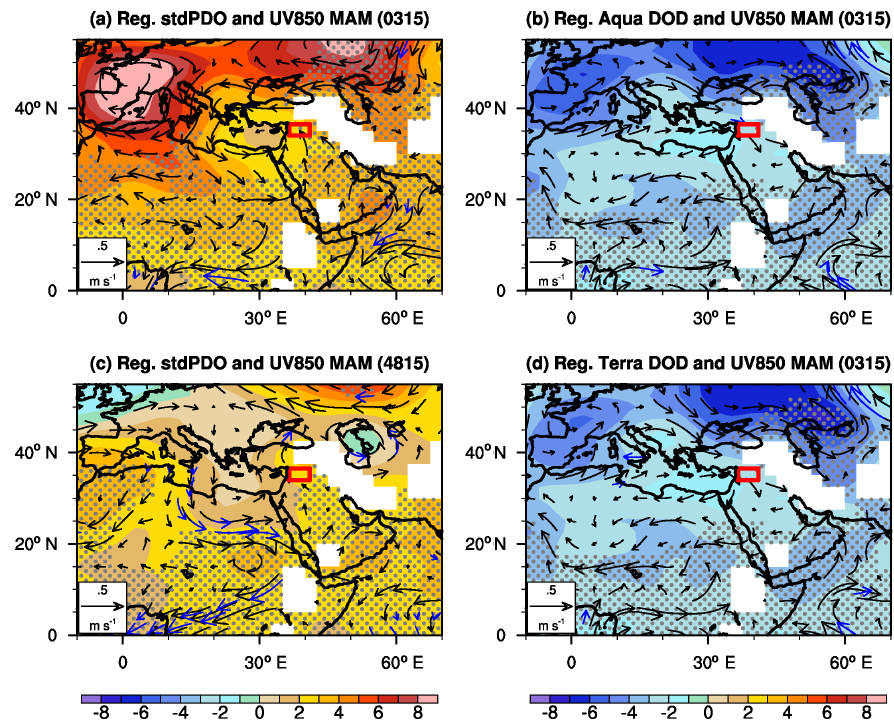
Figure 5. Regressions of NCEP1 850hPa geopotential height (shading; gpm) and horizontal winds (vectors; ms − 1 ) onto the standardized PDO index during (a) 2003–2015 and (c) 1948–2015, and onto the standardized (b) Aqua and (d) Terra DOD indices during 2003–2015. Area where the regression is significant at the 95% confidence level ( t test) is dotted, and vectors significant at the 90% confidence level are plotted in